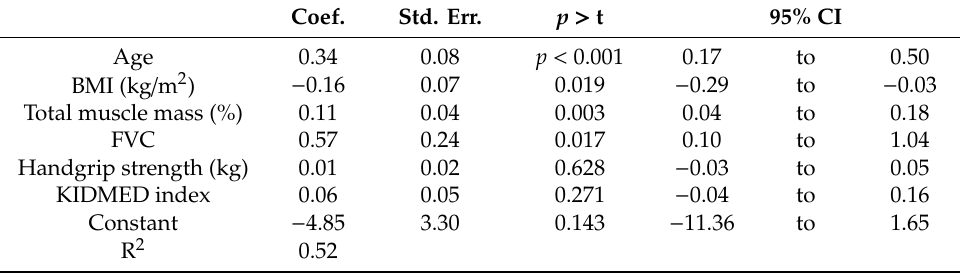
Table 4. Influence of body composition, respiratory variables handgrip strength, and adherence to the Mediterranean diet on cardiorespiratory fitness (stages of the 20-m shuttle run test (20 mSRT)). Coef. Std.